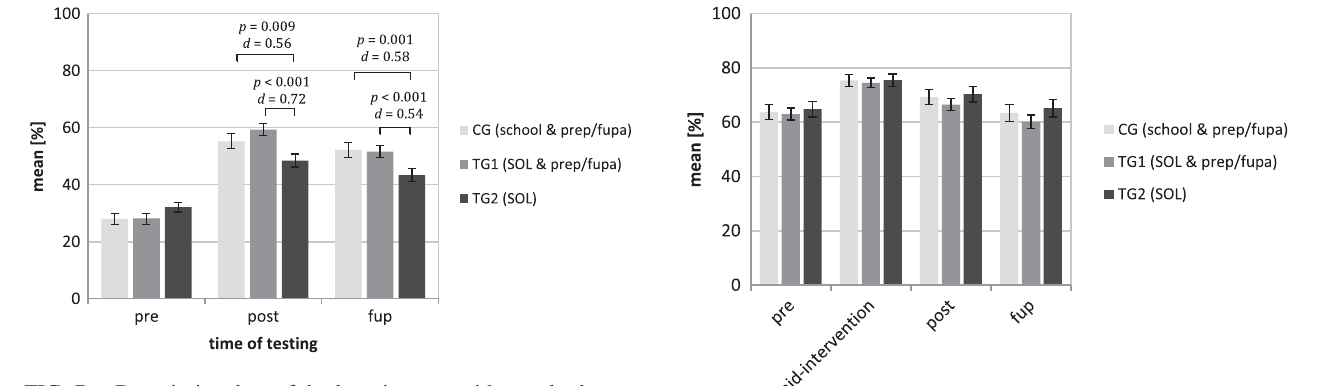
); e ) (abbreviations: cpu_pre: prior conceptual a